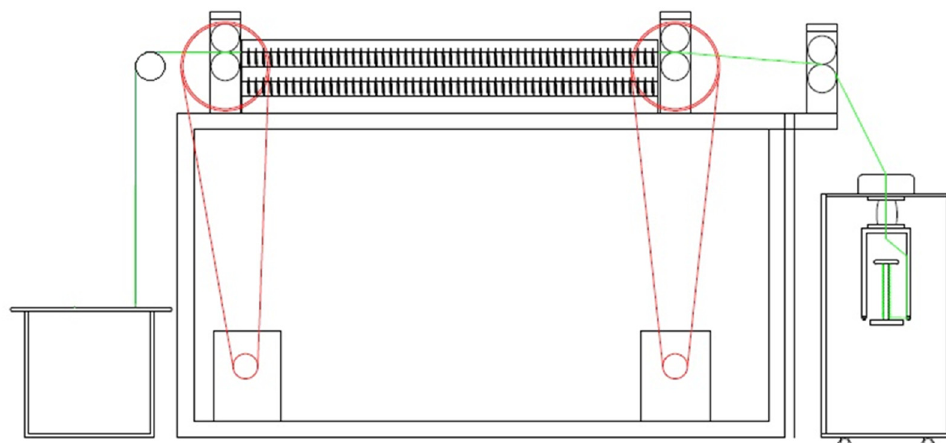
Figure 3. Schematic diagram of the gill-flyer spinning